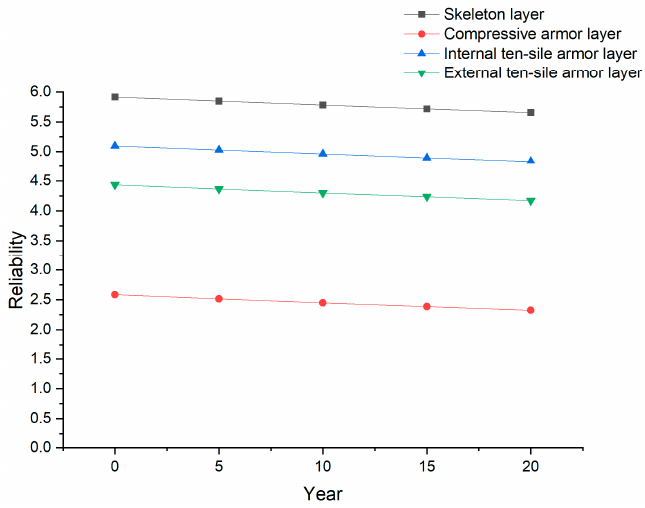
Figure 15. The reliability of metal layer changes with